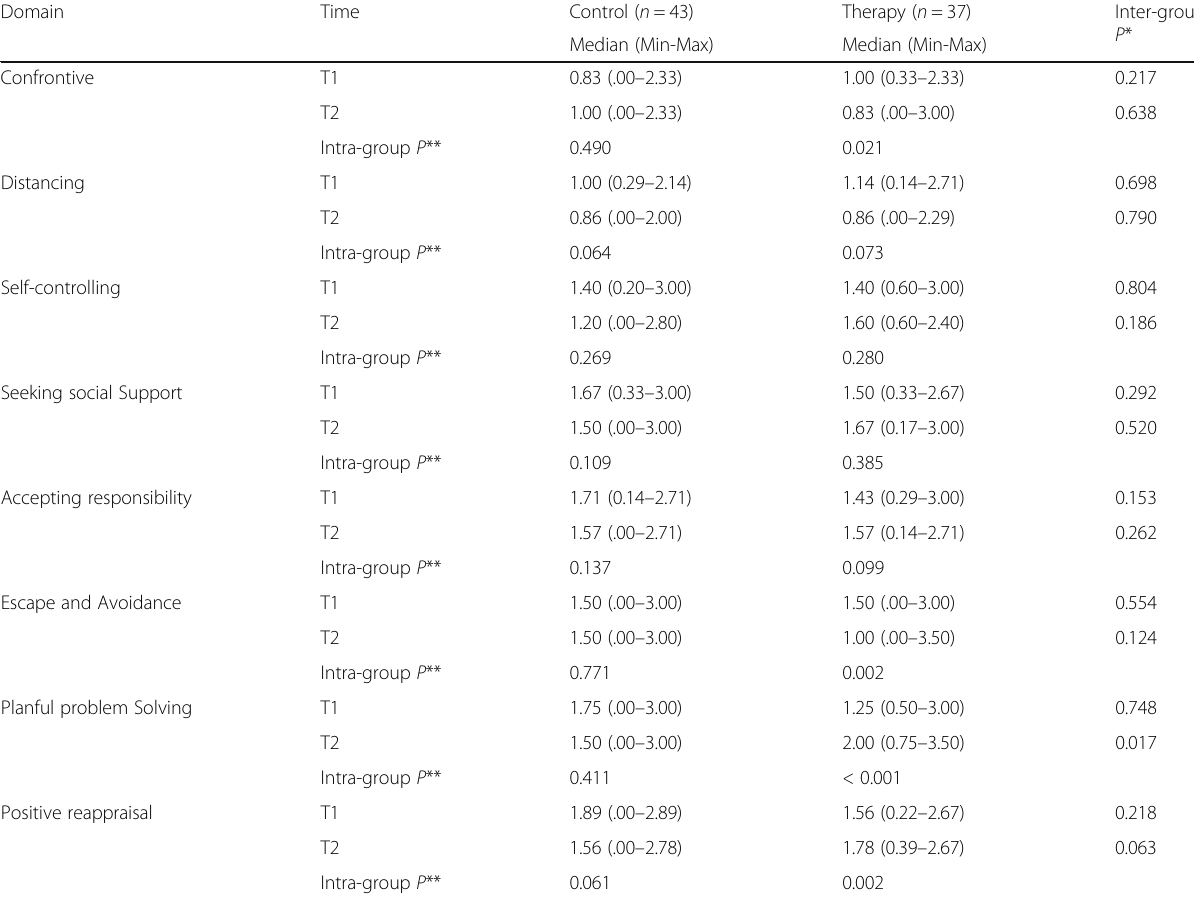
Table 6 Coping scores of SLE patients in control and therapy groups over time Domain Time